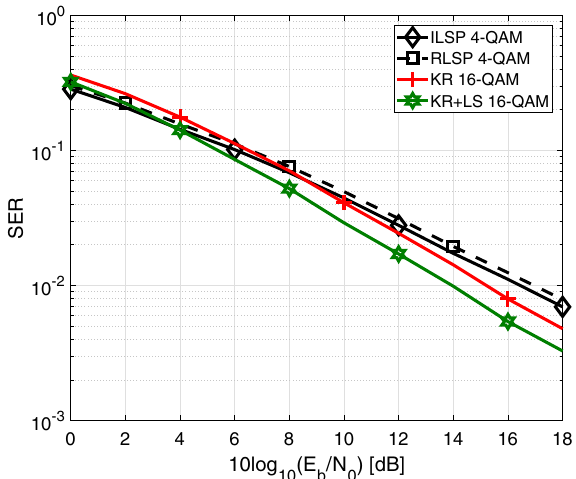
Fig. 5 SER versus E b / N 0 for N = 128 subcarriers, K = 10 blocks, (cid:31) K = 10 , while P = 10 ( K = 5 and Q = 2 ) for the Khatri–Rao-coded MIMO-OFDM